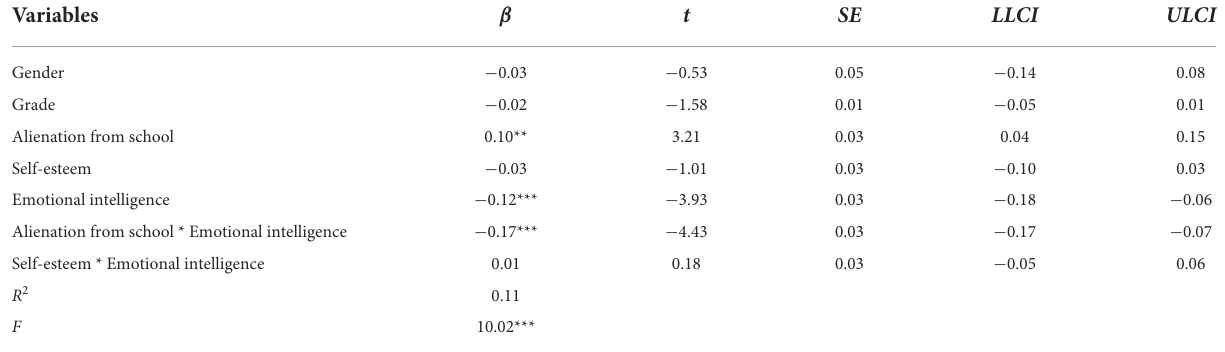
TABLE 3 The moderating model of alienation from school and cyberbullying.